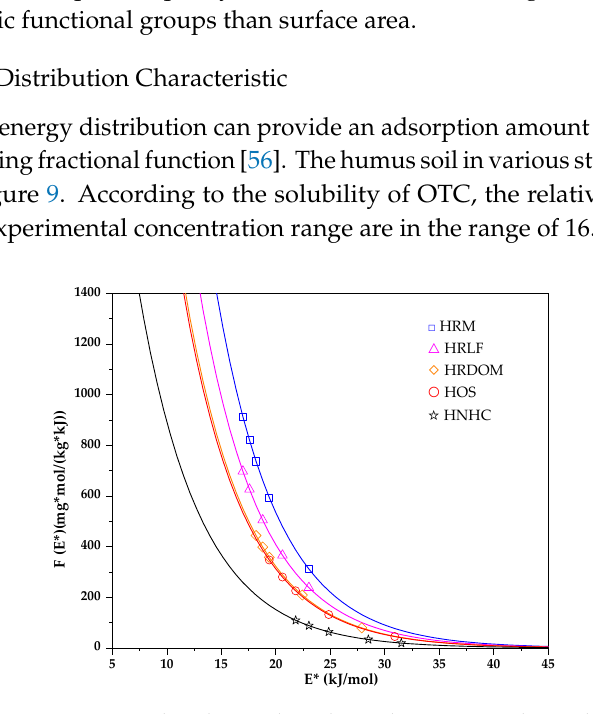
Figure 9. Site energy distribution based on adsorption isothermal model.